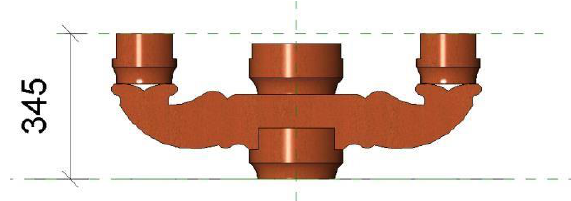
Figure 7. Example of a building component of the Huangxi academy.